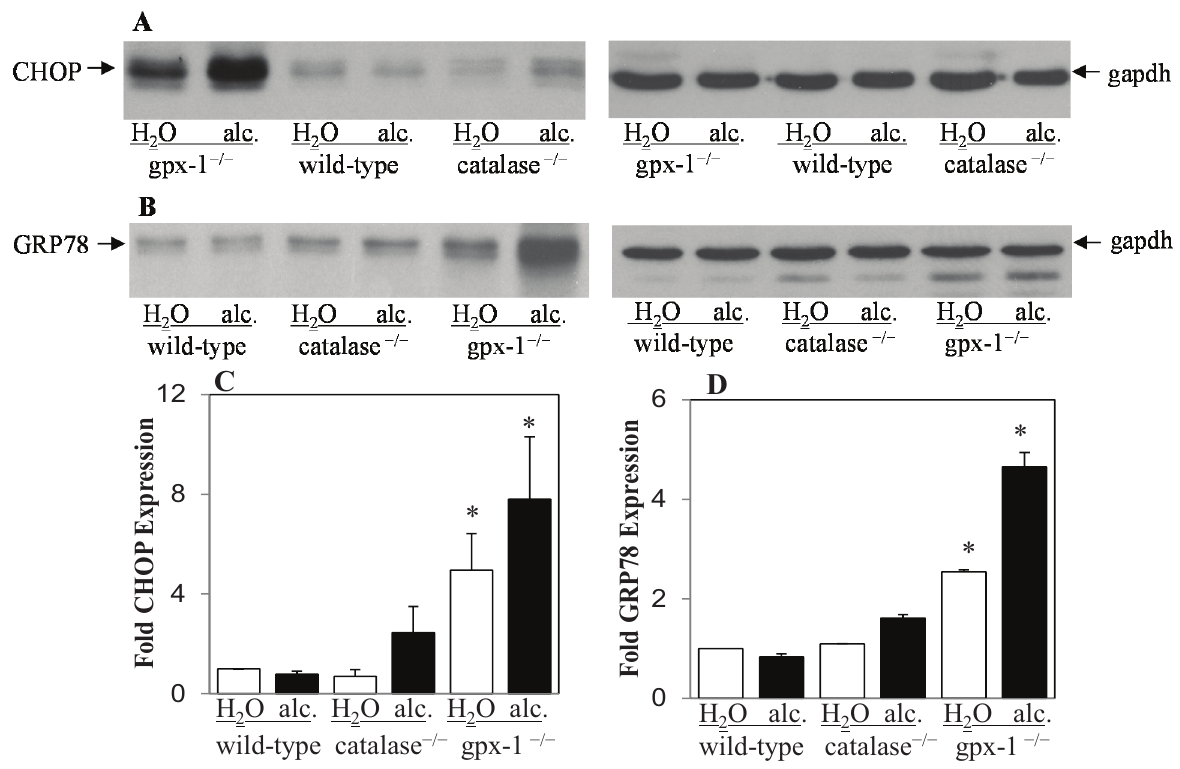
Figure 3 . Liver CHOP (GADD153) and GRP78 (BiP) protein expression. Total cell lysates isolated from the livers of H 2 O or ethanol (alc.)-fed wild-type and gpx-1 (cid:2)/(cid:2) or catalase (cid:2)/(cid:2) transgenic mice were employed to detect CHOP ( A ) or GRP78/BiP ( B ) protein expression by western blotting. An anti-gapdh antibody was used to demonstrate equal protein loading. CHOP ( C ) and GRP78 ( D ) expression was quantified by densitometric analysis and normalized to gapdh expression, respectively. Normalized expression in H 2 O or alcohol-fed knockout and alcohol-fed wild-type mice was expressed as fold expression of that in H 2 O-fed wild-type mice. Asterisks indicate statistical significance ( p <